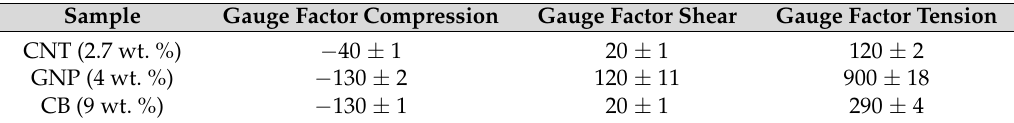
Table 3. Sensitivity values (gauge factor) in a linear range (up to 1% deformation) of nanostructured sensor fiber using different carbon filler (CNT, GNP, CB) embed in the planes of maximum stresses for compression, shear and tension, during a quasi-static three-point bending test.